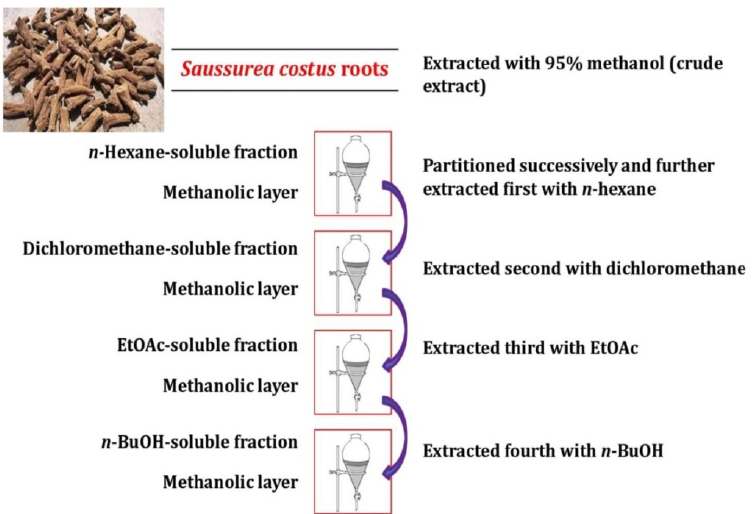
Figure A1. Saussurea costus root crude extraction and solvent-solvent fractionation scheme.